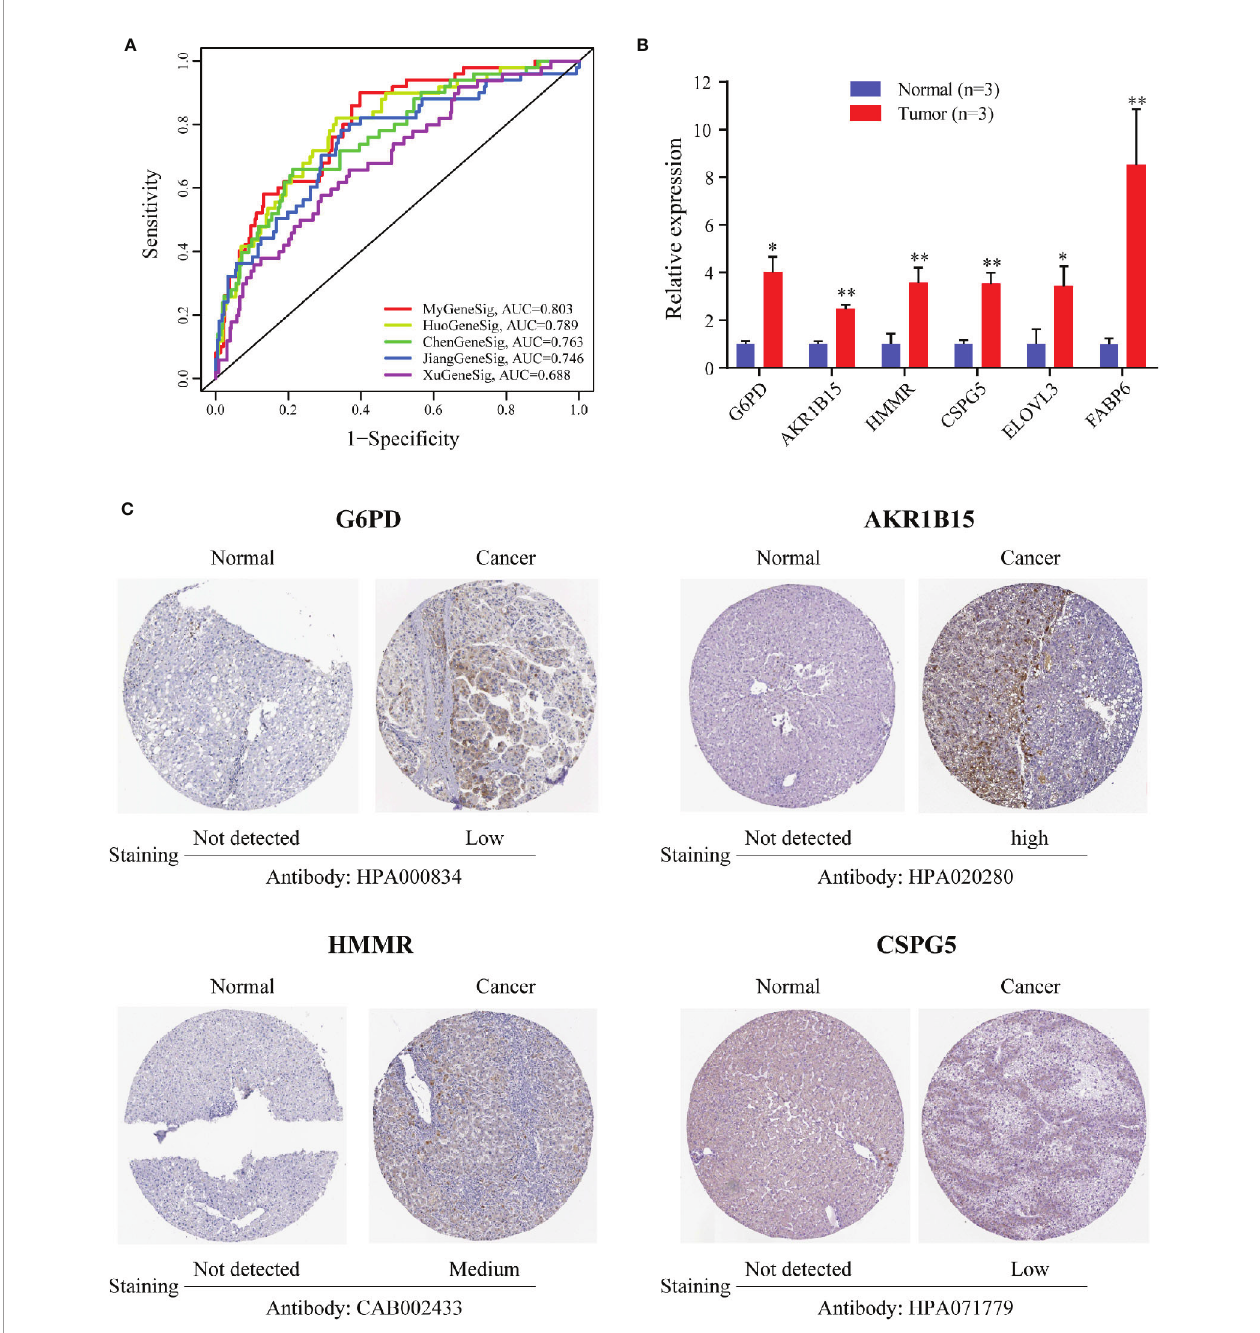
FIGURE 4 | The expression level of six genes in HCC. (A) The ROC analysis at 1 year of overall survival for the MyGeneSig, HuoGeneSig, ChenGeneSig, JiangGeneSig, and XuGeneSig. (B) The mRNA expression analysis by qRT-RCR. (C) The immunohistochemistry staining images of G6PD, AKR1B15, HMMR and CSPG5 from the HPA. * P <0.05; ** P